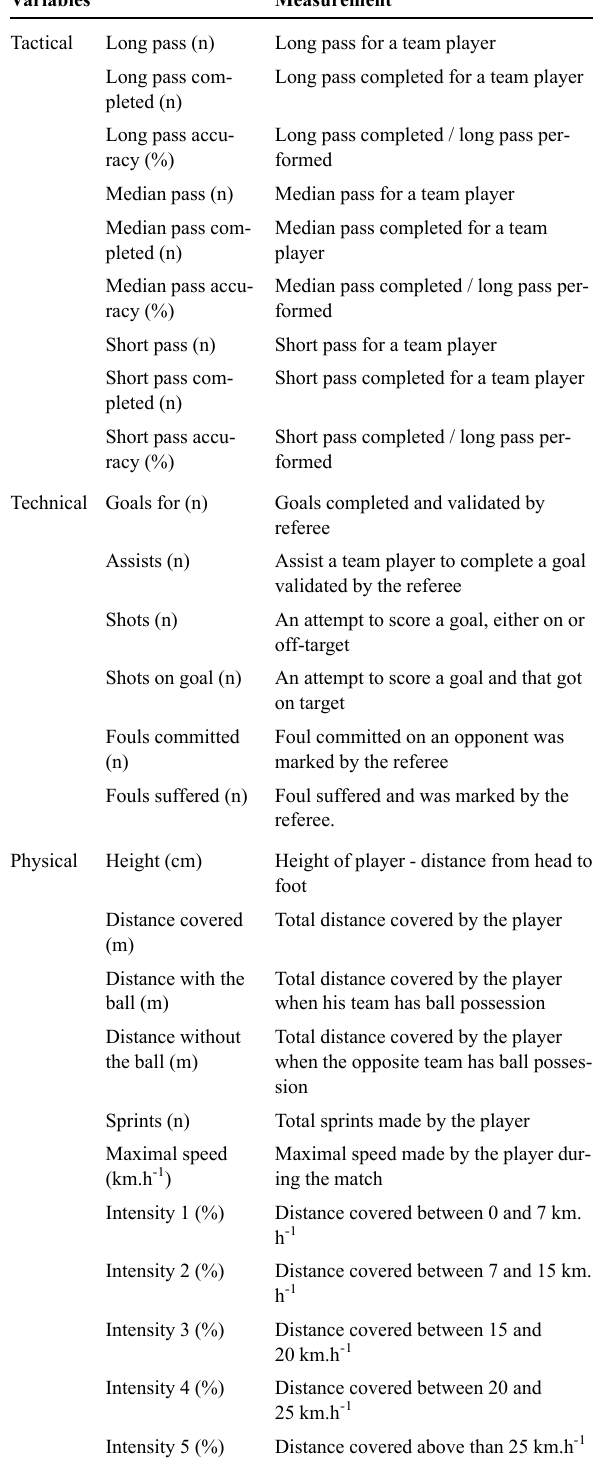
Table 1 - Tactical, technical, and physical variables were analyzed between selected and unselected